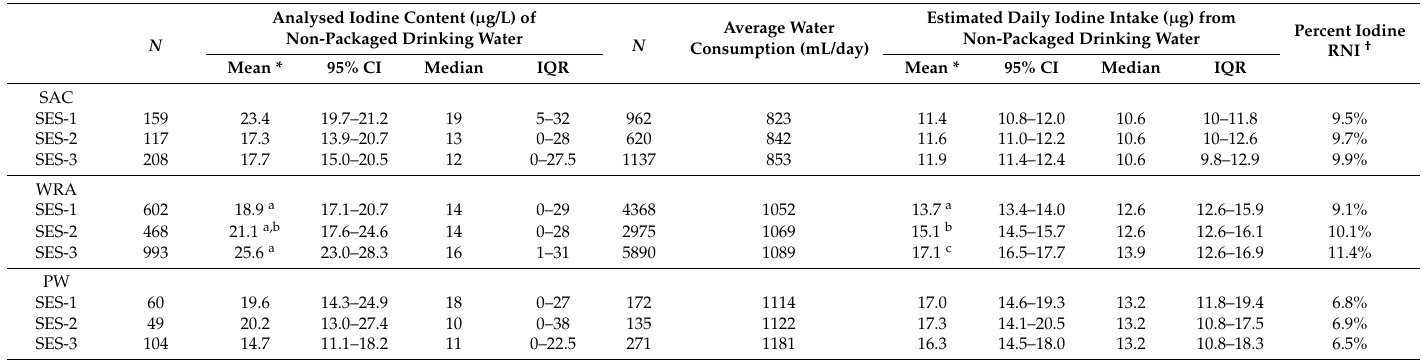
Table 6. Mean and median iodine contents of non-packaged drinking water ( µ g/L) and estimated daily iodine intakes ( µ g) and percentages of RNI from non-packaged drinking water by household SES